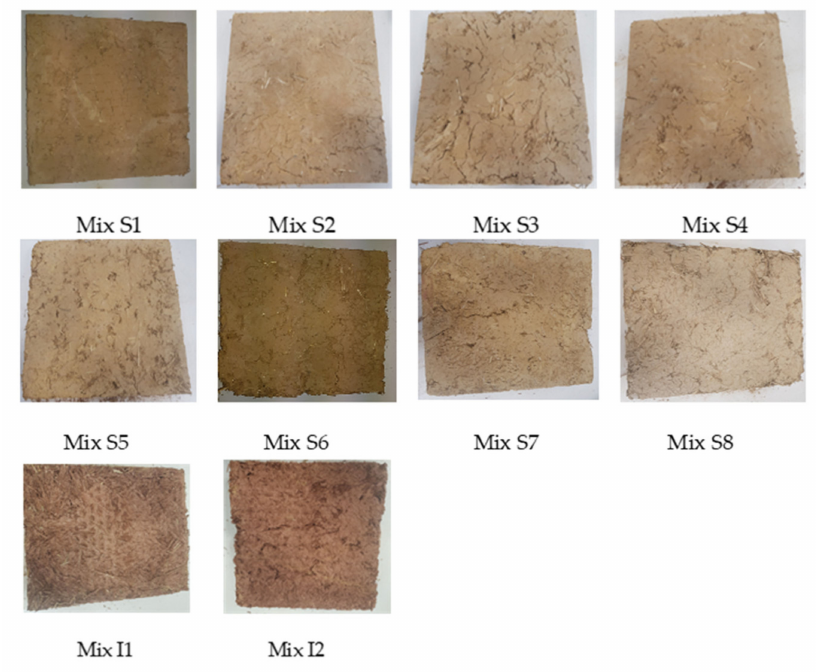
Figure 2. Photos of the studied structural and insulation cob